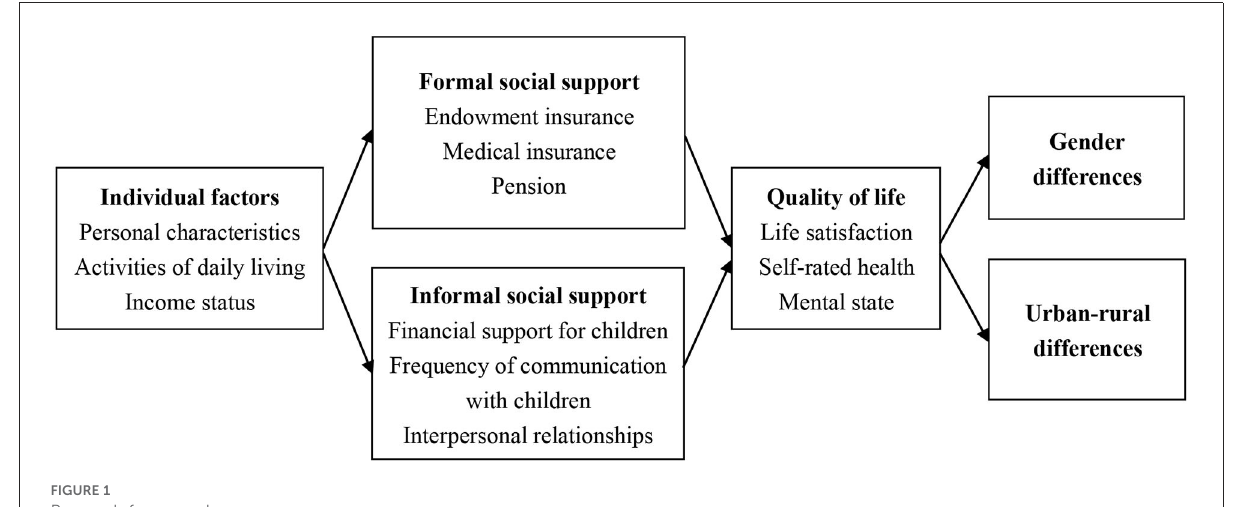
FIGURE1 Research